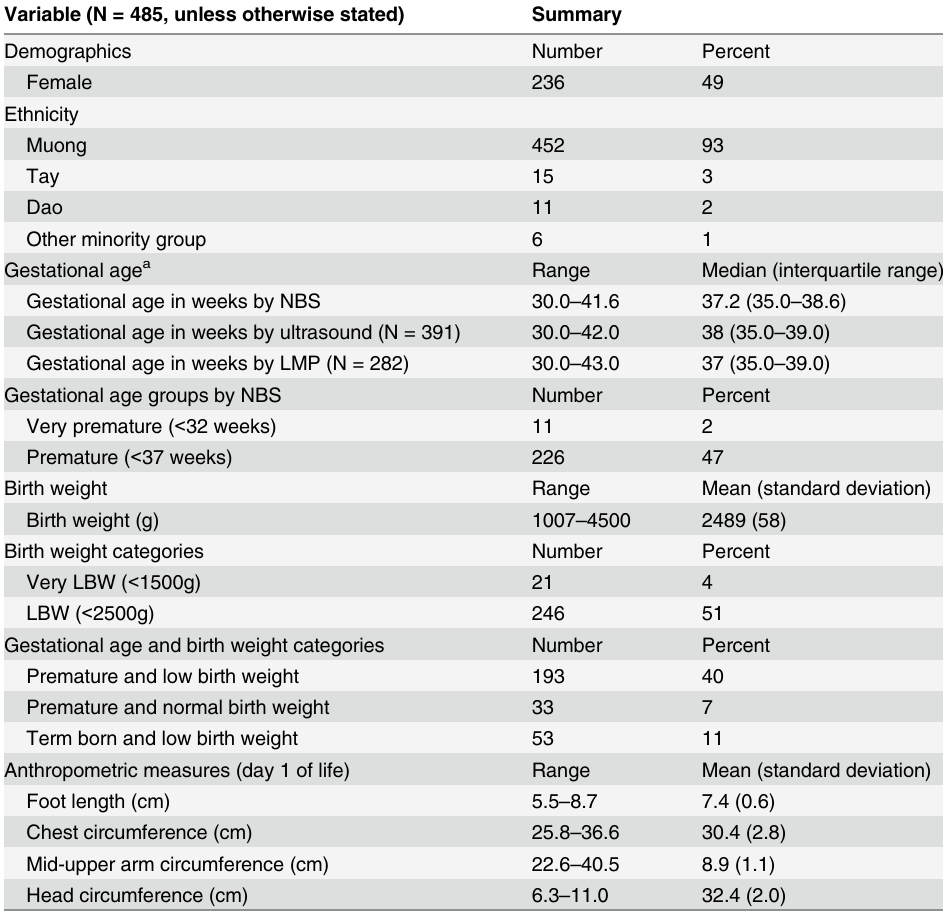
Table 1. Demographic and clinical characteristics of the study participants (N =